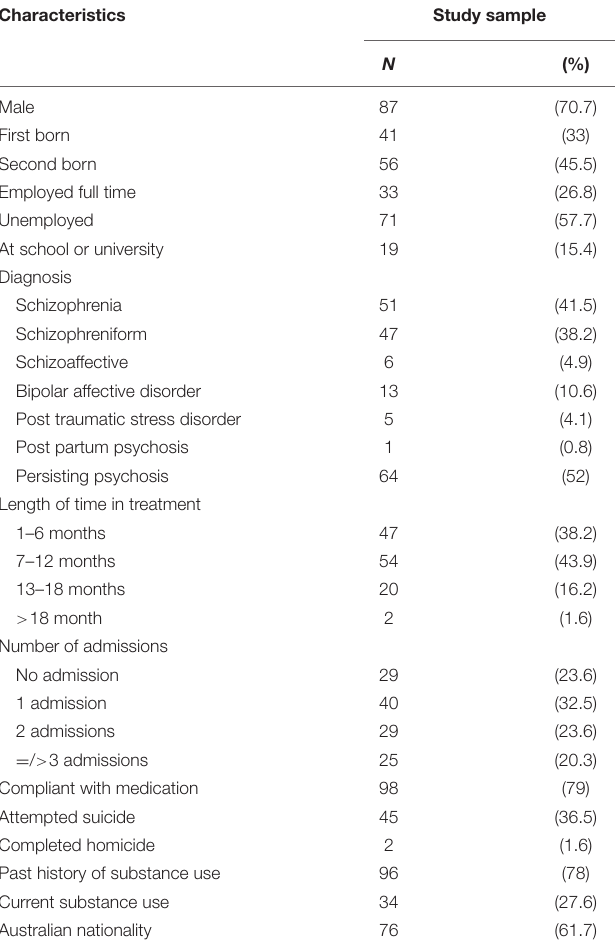
TABLE 2 | Sociodemographic characteristics of young people with early psychosis obtained from medical record ( n = 123).